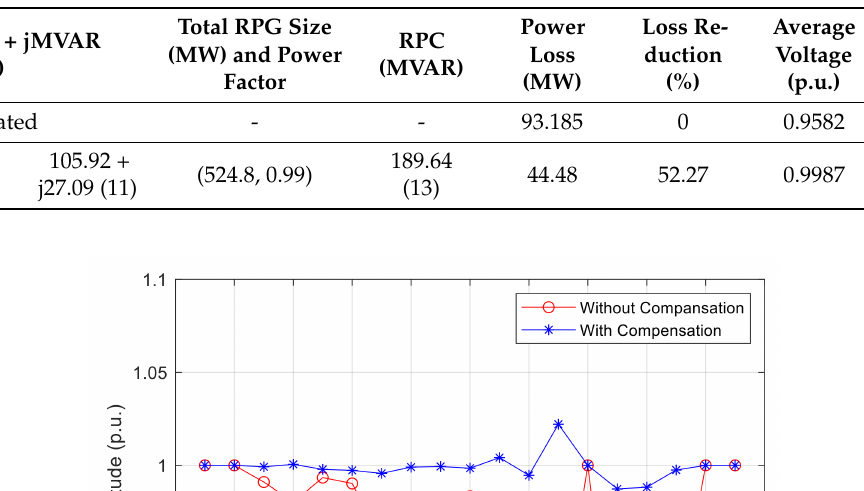
Table 7. Integrated operations of RPC and RPGs at 0.85 PF.